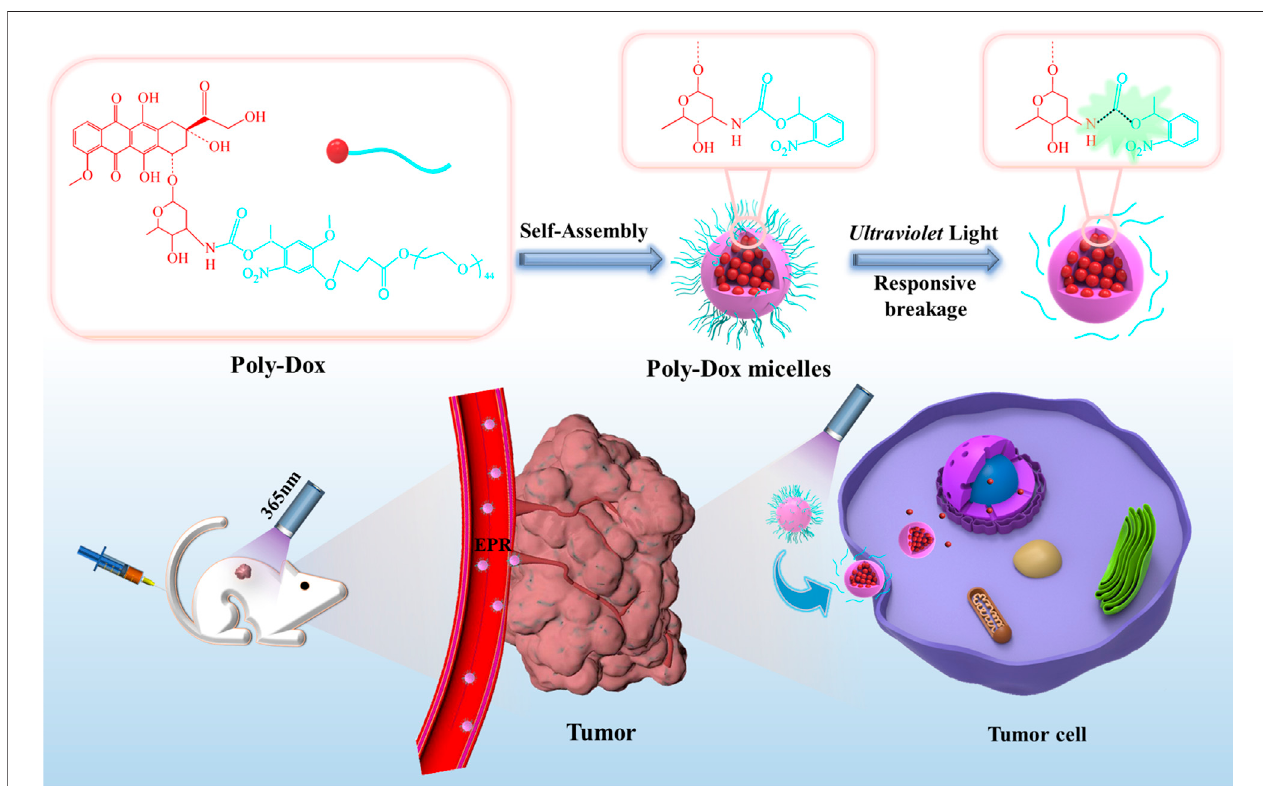
SCHEME 1 | Schematic illustration of the self-assembly and responsive breakage of Poly-Dox micelles, and the process of tumor therapy.